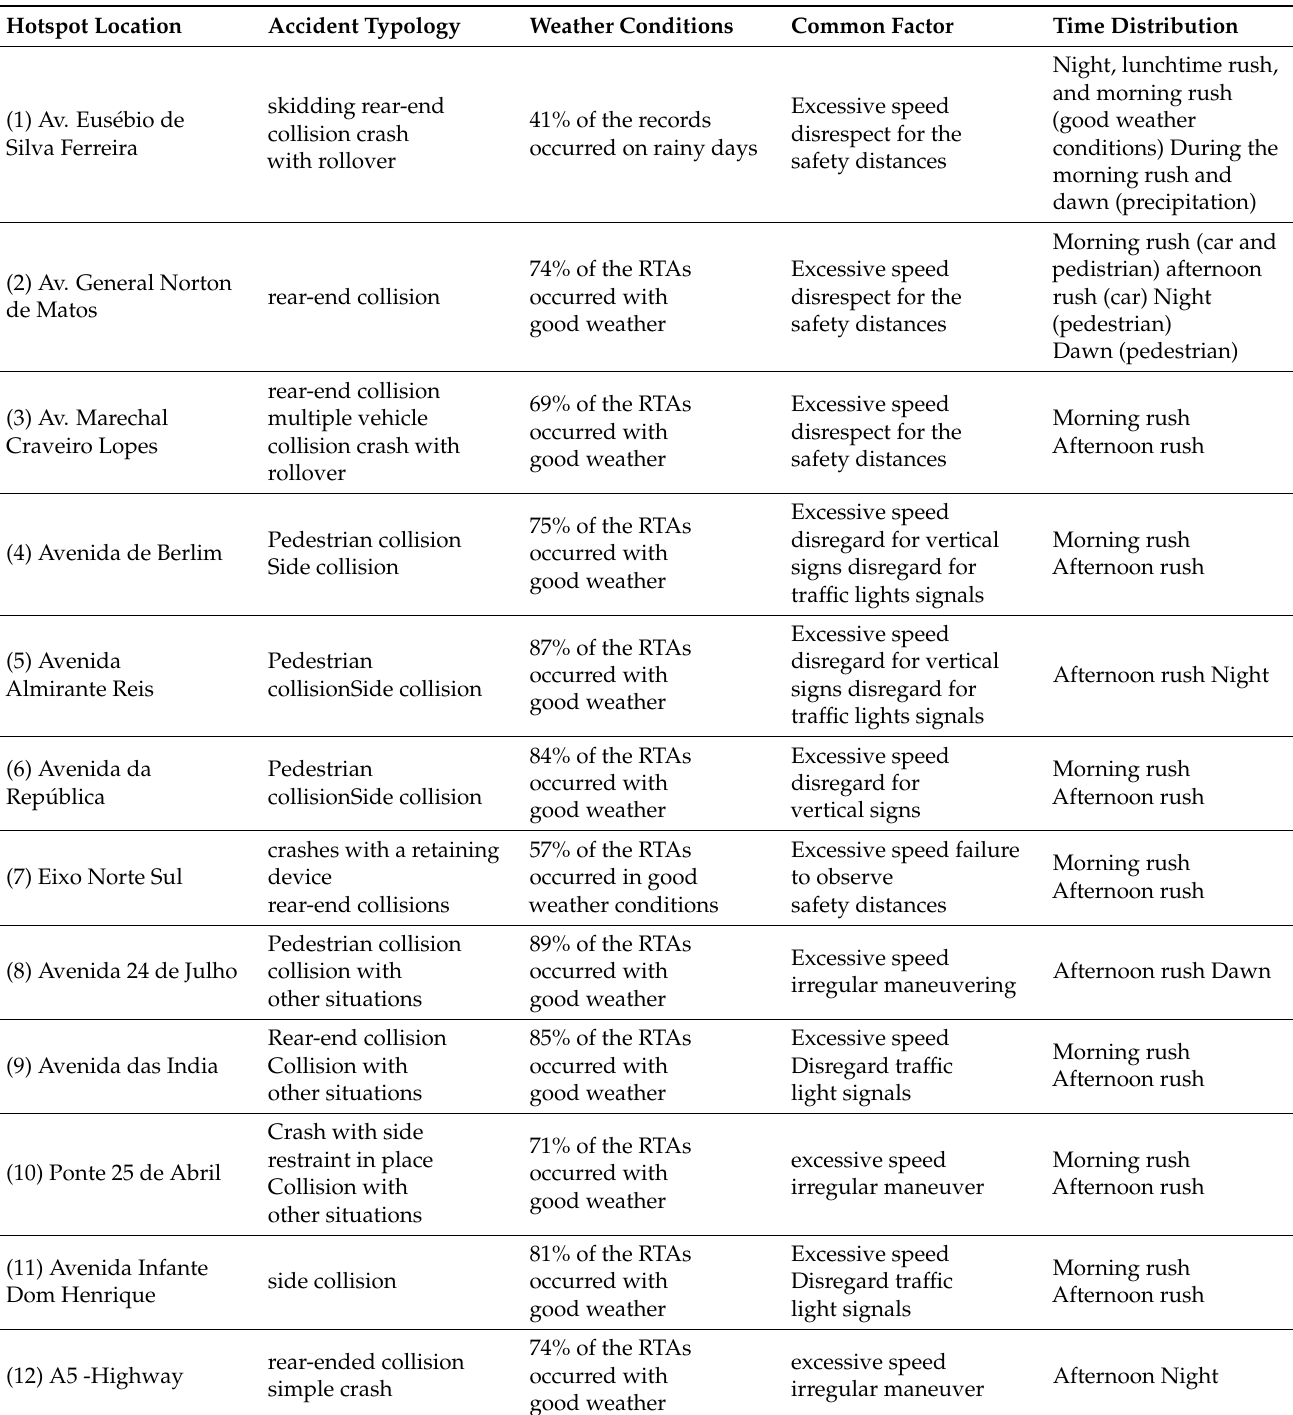
Table 2. Analysis between